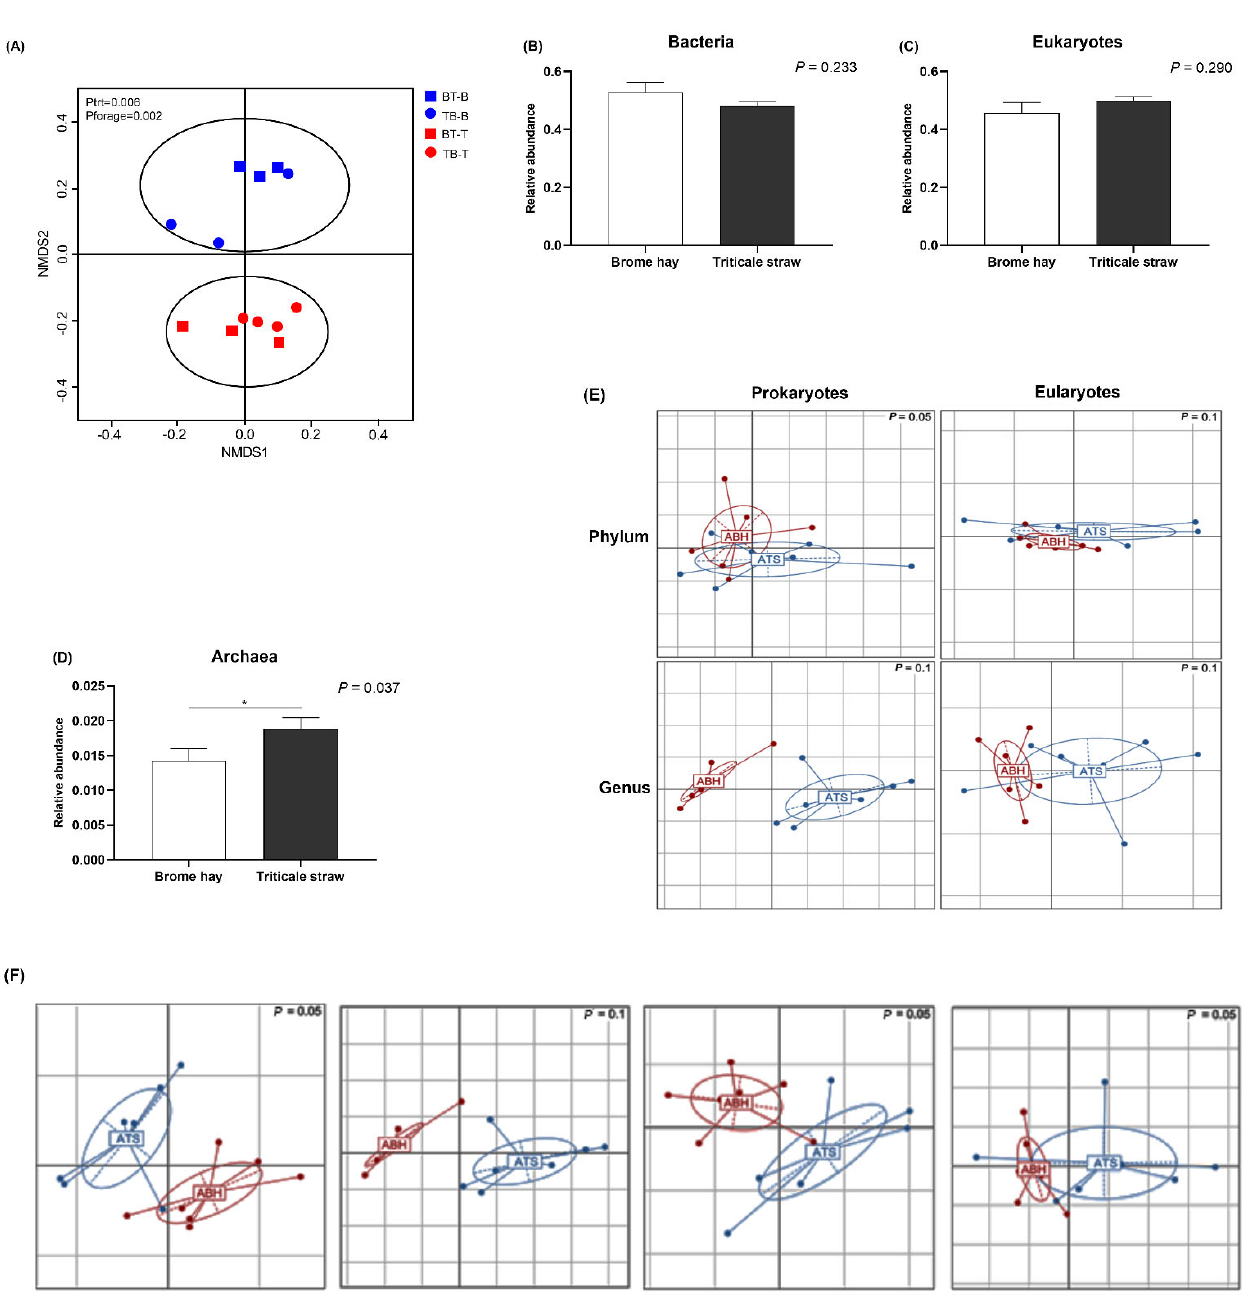
Figure 1. The structure of microbial community response to forages scenario. ( A ) the effect of feeding stages, feeding order, and forages scenario on the structure microbiome was analyzed. The composition of microbiota in ( B ) bacteria, ( C ) eukaryotes, and ( D ) archaea of muskoxen rumen. Between-classes PCA revealing the differences of microbial population structure of solid-phase rumen contents from muskoxen in two groups crossover fed either triticale straw (blue circle noted) or brome hay (red circle noted) in term of ( C ) prokaryotes and eukaryotes at the levels of phylum and genus, as well as ( D ) in population structure of bacteria, archaea, fungi, and protozoa at the genus level. The statistical significance of the between-classes PCA, as determined by a Monte-Carlo test (n = 999), gave P ≤ 0.05 in all four cases. The letters of ATS and ABH refer to the muskoxen fed triticale straw in autumn and brome hay in autumn, respectively. * P < 0.05.